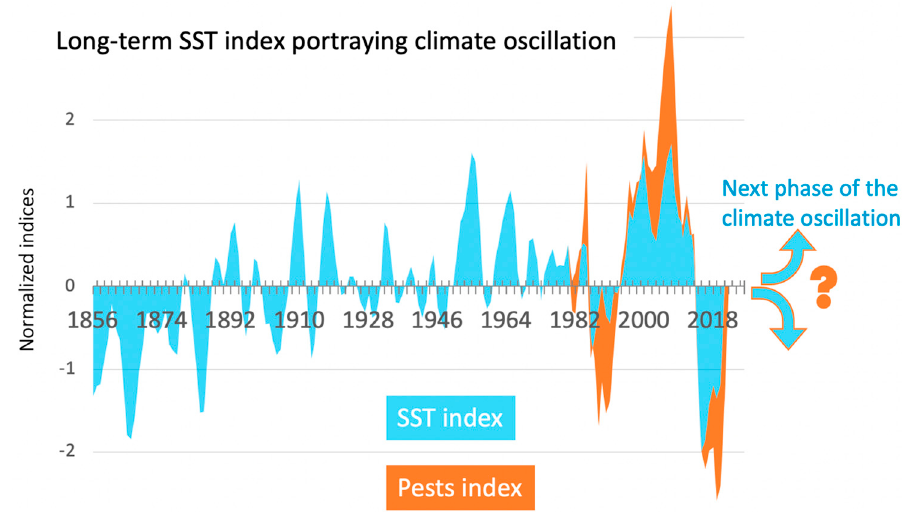
Figure 6. Long-term SST Index derived from the Kaplan SST data indicating the oceanic climate oscillation in blue overlaid with the Pest Index (annual mean all species rice planthoppers) in orange. The arrows on the right illustrate possible phase reversal of the natural climate variability in the future and how the Pest Index may change correspondingly.